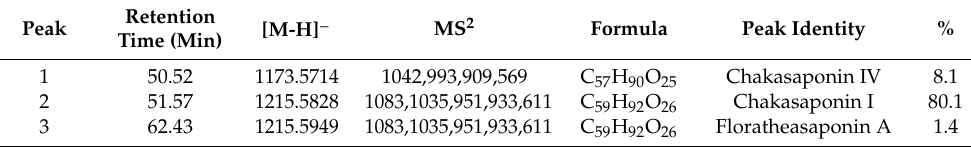
Figure 1. Characteristic of purified tea flower saponins (PTFSs). ( a ) Base peak chromatogram of PTFSs. ( b ) Chemical structures of Chakasaponin I, Chakasaponin IV and Floratheasaponin A [25,26]. Table 1. Mass spectrometry data in negative mode for saponins identified from PTFSs.